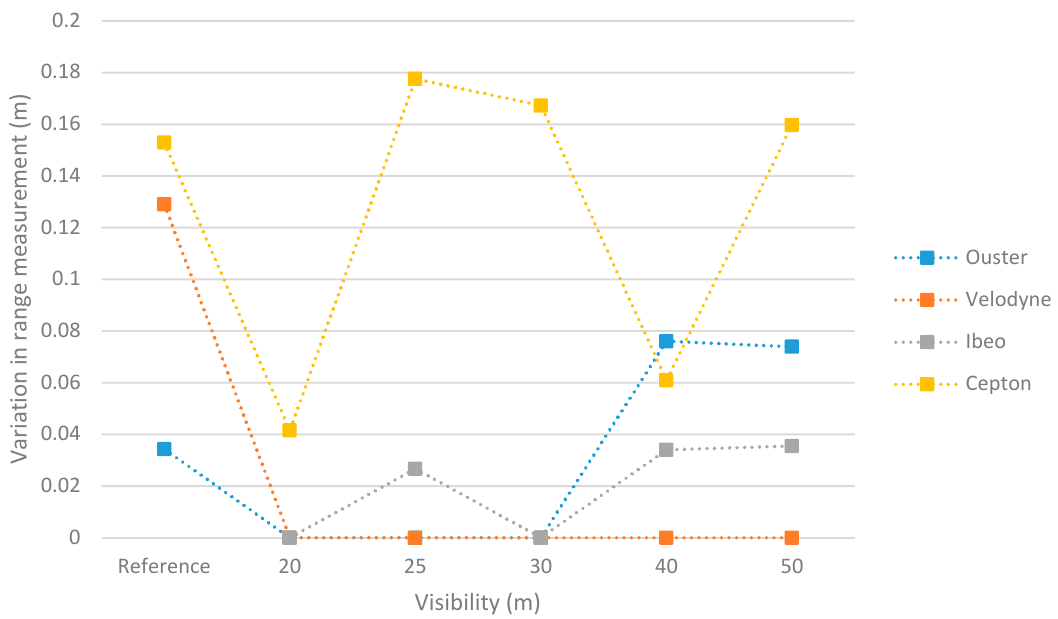
Figure 8. Standard deviation of range values from echo points reflected from the 90% target located at 20 m.